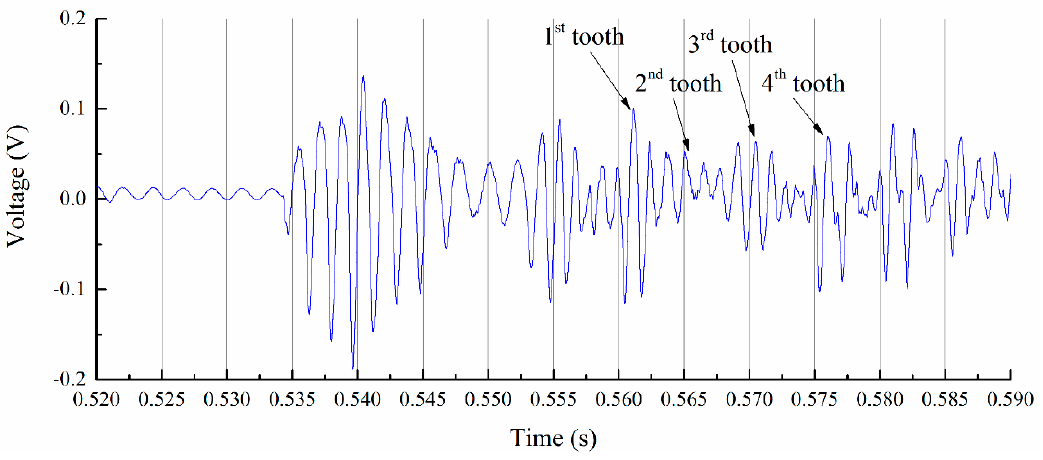
Figure 7. Initial cutting stage.